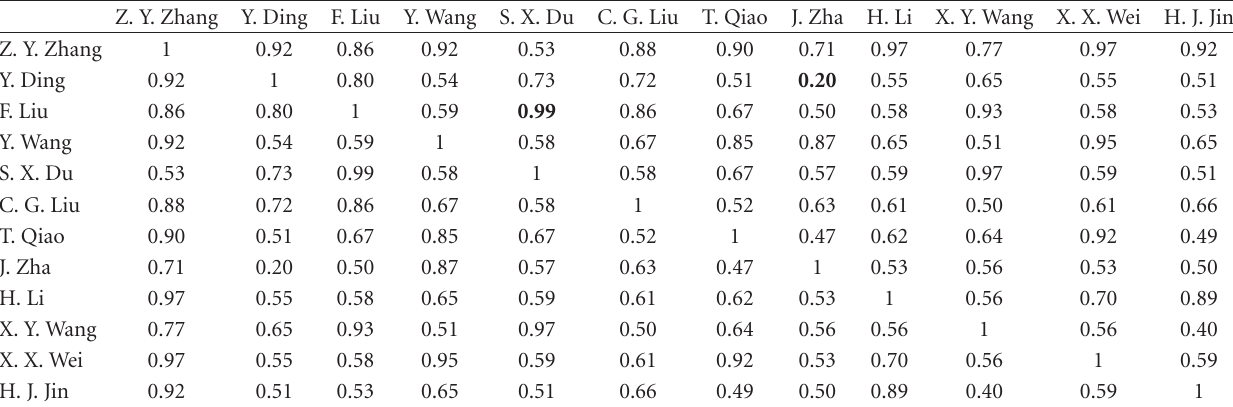
Figure 4: Weighted network of entities within an Internet social network. Table 2: Similarity degrees of 12 user